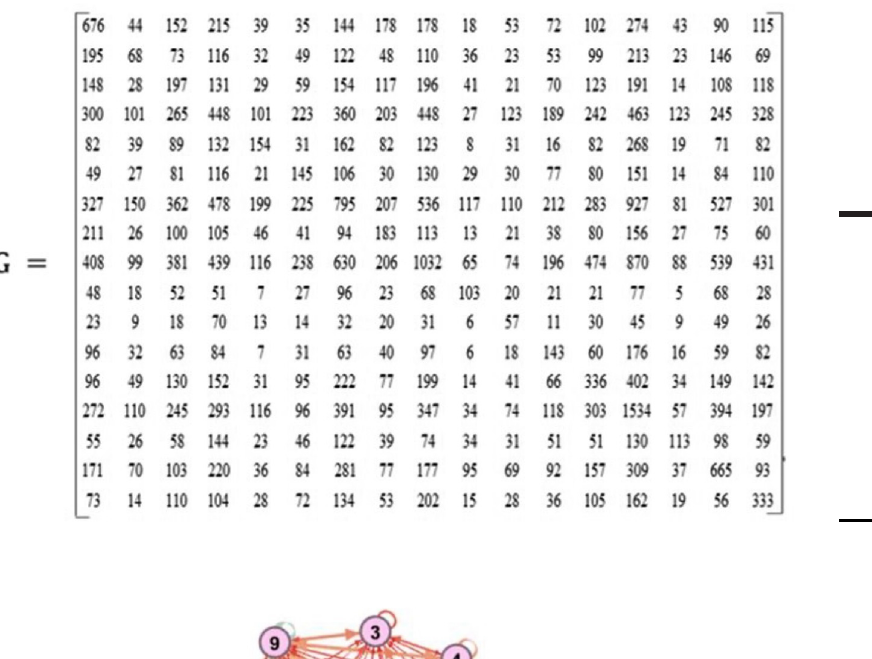
Figure 4. Primitive cross- domain knowledge exchange network between knowledge